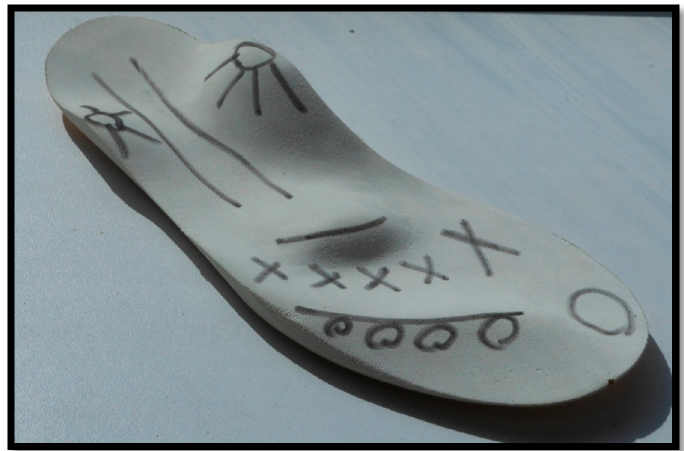
Figure 2. Sensorimotor orthosis with descriptive markings.